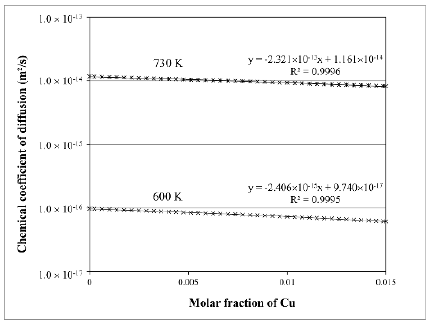
Figure 5. Coefficient of diffusion as a function of the Cu molar fraction in an Aluminum rich matrix at 600 K and 730 K, estimated with Thermo-Calc and the databases TCAL5 [13] and MOBAL1 [14].